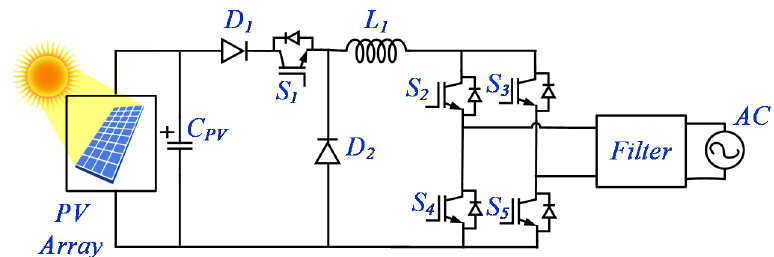
Figure 13. Universal single-stage grid-connected inverter.